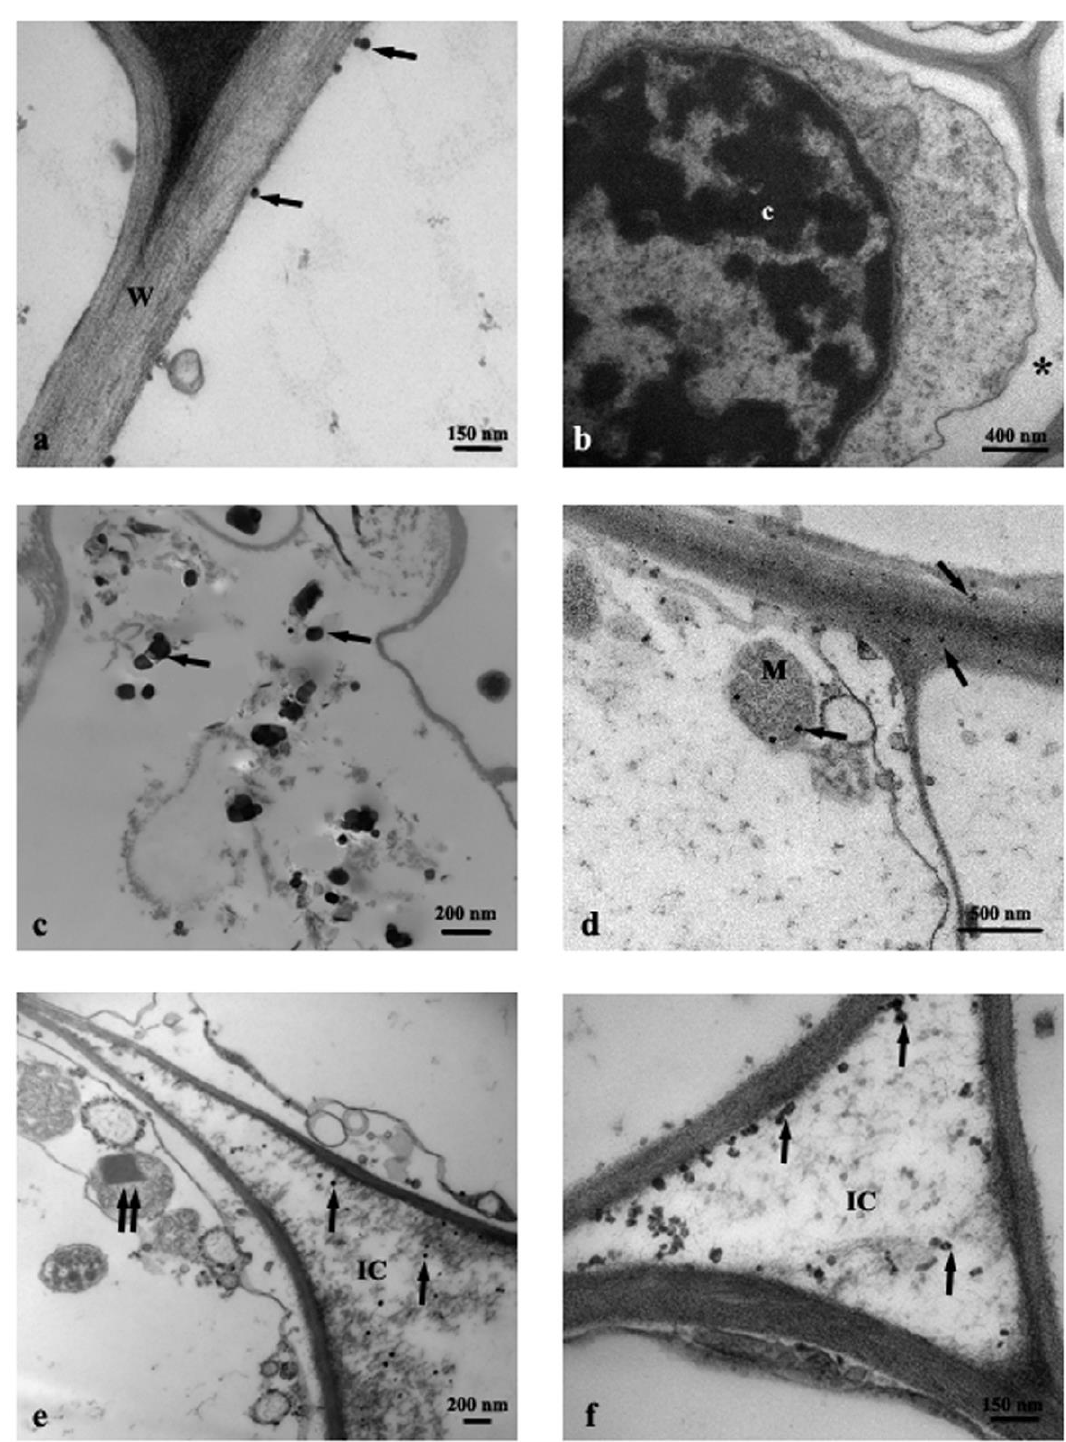
Figure 2. TEM images of roots cross-section: ( a ) C, control, NPs (arrows); ( b ) C, control, plasmalemma-wall detachment (asterisk); ( c – f ) Ana800 treatment, NPs (arrows), a crystal in a mitochondrion (double arrow). c, chromatin; IC, intercellular space; M, mitochondrion; W, cell